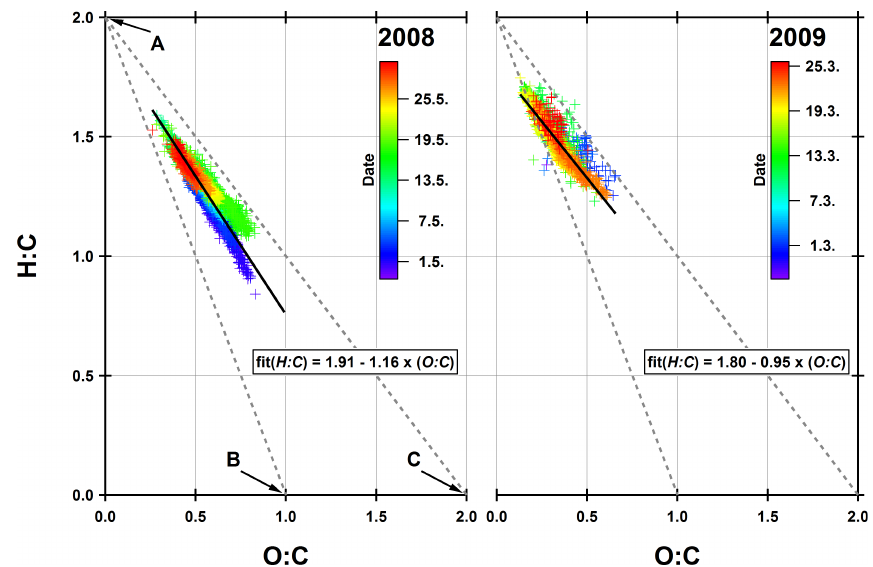
Fig. 12. van Krevelen diagram presenting the H:C and O:C ratios for the two campaigns in May 2008 (left) and March 2008 (right), respectively. The data is colored by time and the result of a linear regression (black solid line) is shown. Transformation from CH 2 to CO and CO 2 is indicated by the left ( A to B ) and right ( A to C ) dashed grey line,